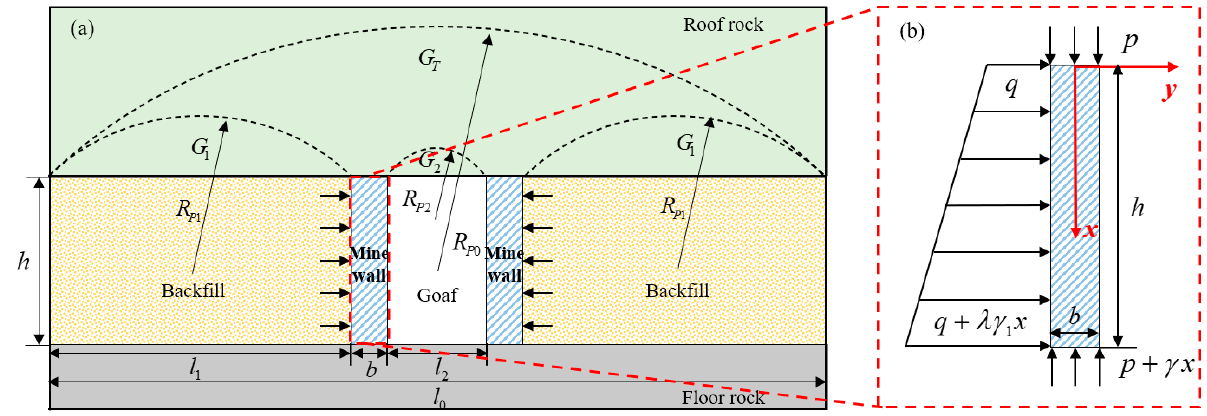
Figure 2. ( a ) Bearing mechanism diagram of the backfill–mine wall system. ( b ) Mine wall mechanic model. In Figure 2a: G T is the total weight of the overlying surrounding rock of the backfill– mine wall system; G 1 is the self-weight of the upper surrounding rock for the backfill; G 2 is the self-weight of the caving surrounding rock in the isolated pillar goaf; R P 0 is the equivalent radius of the plastic zone of the backfill–mine wall system; R P 1 is the equivalent radius of the upper plastic zone of the backfill; R P 2 is the equivalent radius of the plastic zone in the upper part of the goaf; l 0 is the span of the backfill–mine wall system; l 1 is the width of the mine room; l 2 is the span of the goaf. In Figure 2b: p is the initial upper load; q is the initial lateral load; λ is the lateral pressure coefficient; γ 1 is the bulk density of the backfill; γ is the bulk density of the mine wall; h is the height of the mine wall; b is the width of the mine wall, x is the vertical distance from the origin of the coordinates, y is the lateral distance to the origin of the